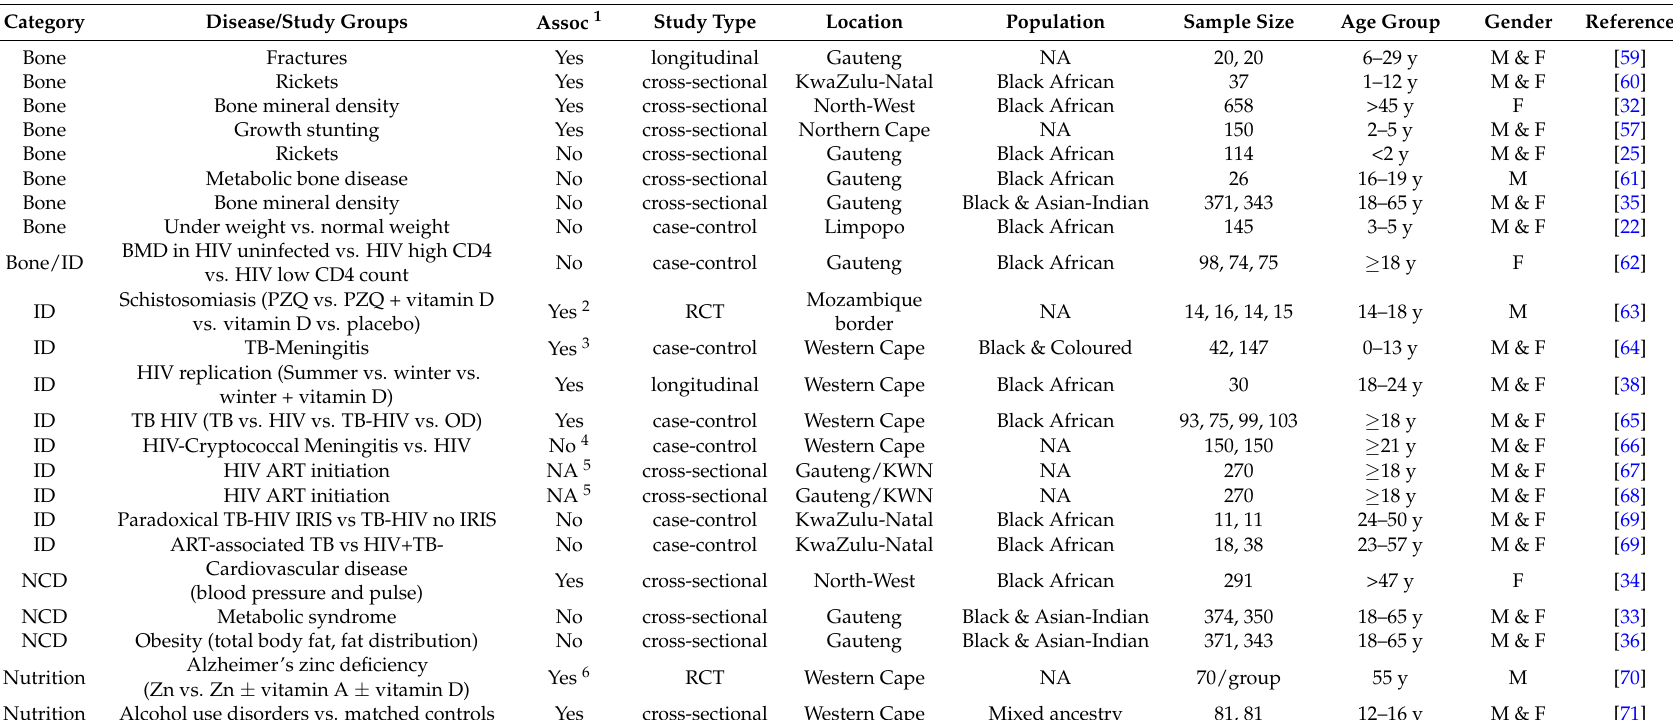
Table 3. Vitamin D deficiency and disease associations in South African populations, by disease, ethnicity, location, age and gender.